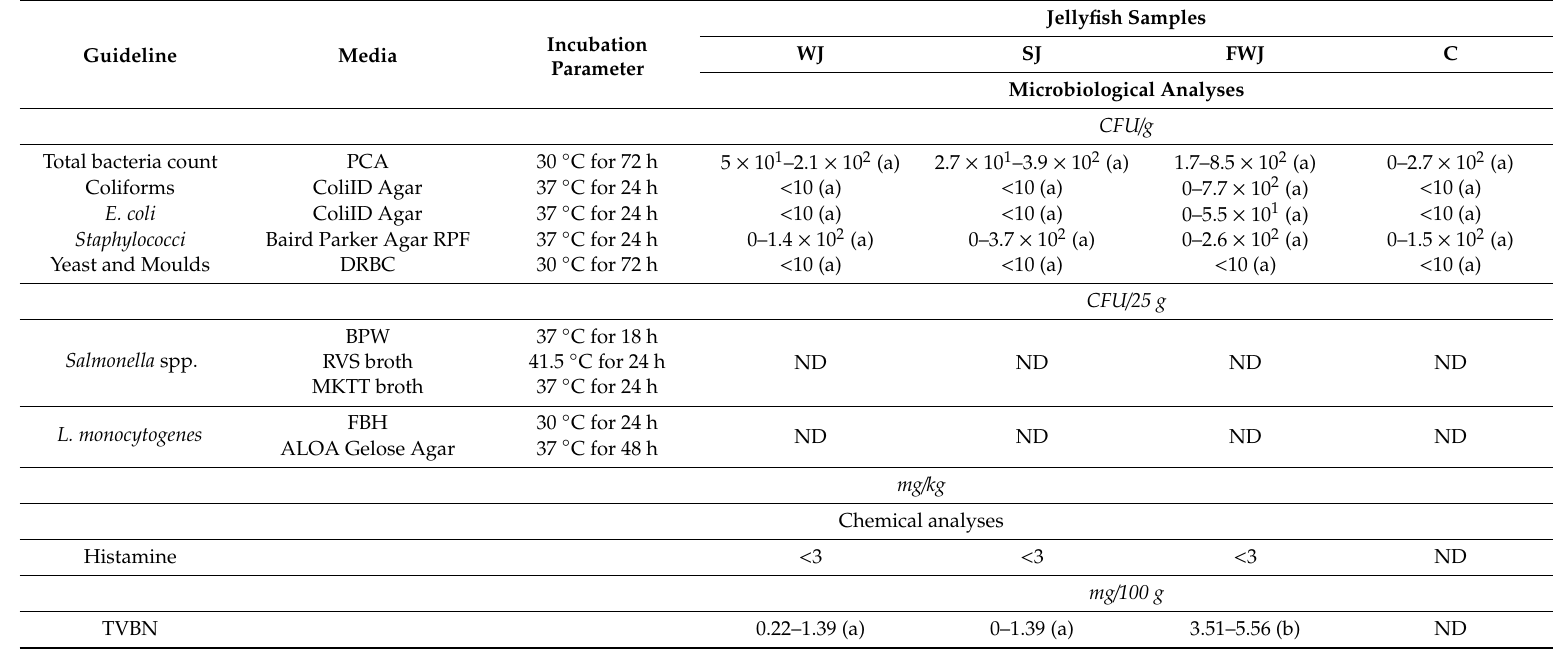
Table 2. Safety and quality selected parameters applied to jellyfish (JF) and seawater samples following accredited conventional assays used for seafood and fish-derived products. Average of data obtained in four sampling periods (June, July, August and October 2018). Data were submitted to one-way analysis of